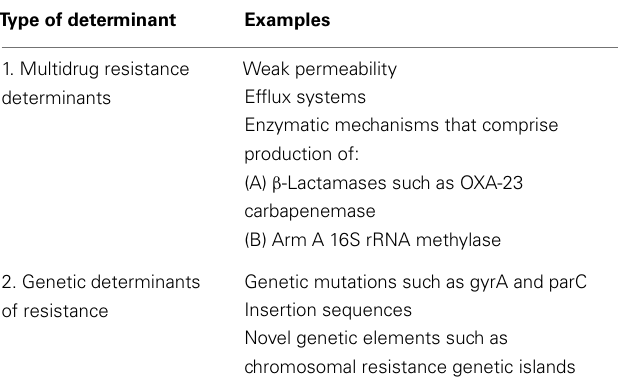
Table 3 | Determinants of drug resistance in A. baumannii